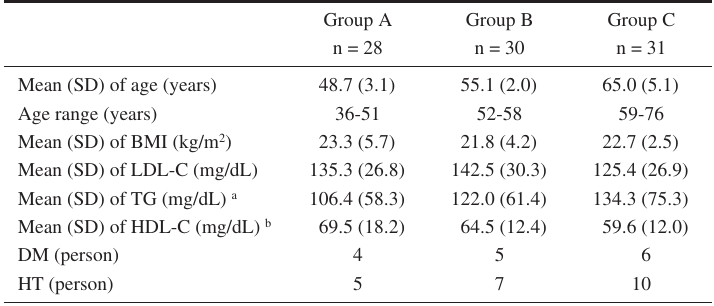
BMI, body mass index; LDL-C, low-density lipoprotein cholesterol; HDL-C, high- density lipoprotein cholesterol; TG, triglyceride; DM, diabetes mellitus; HT, hyperten- sion; SD, standard deviation; Group A, bottom third of age; Group B, middle third of age; Group C, upper third of age.